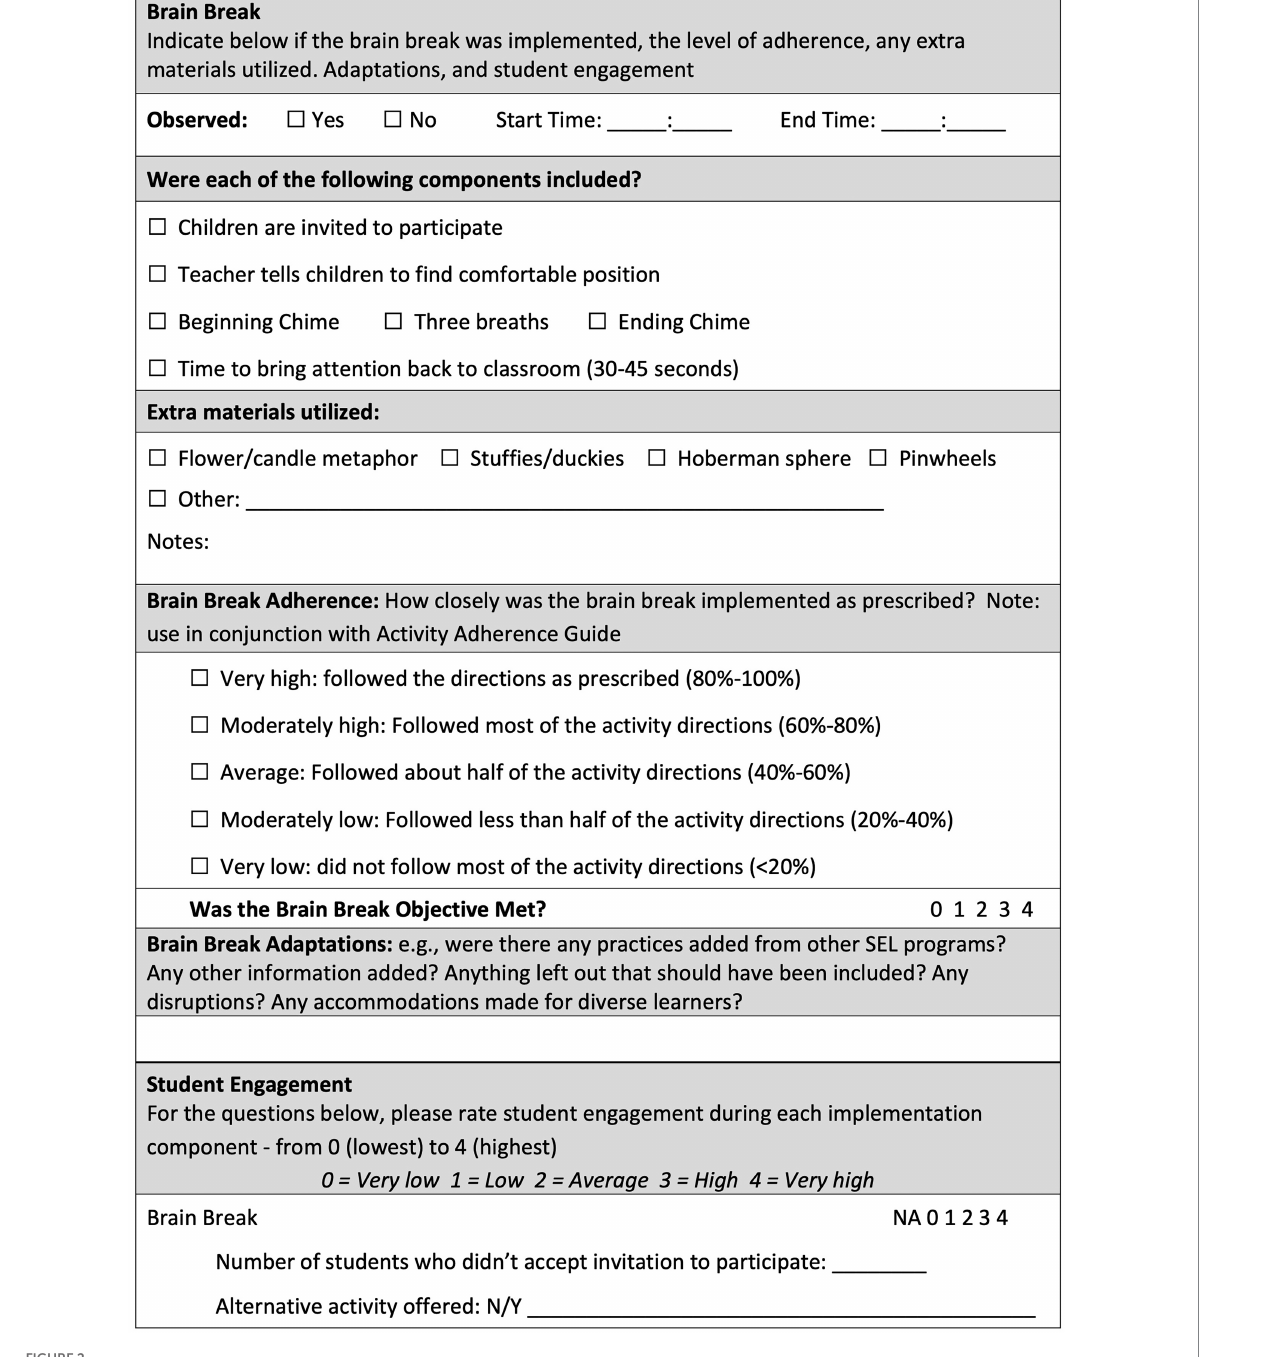
FIGURE 2 Example of third-party observer ratings of the brain break practice: adherence, adaptations, and student responsiveness. Dosage was additionally measured by student attendance during the observation session. Quality of the teacher’s implementation was rated once for the observation session, such that quality scores comprise both the curriculum activity and brain break. Neither of these measures are represented in this